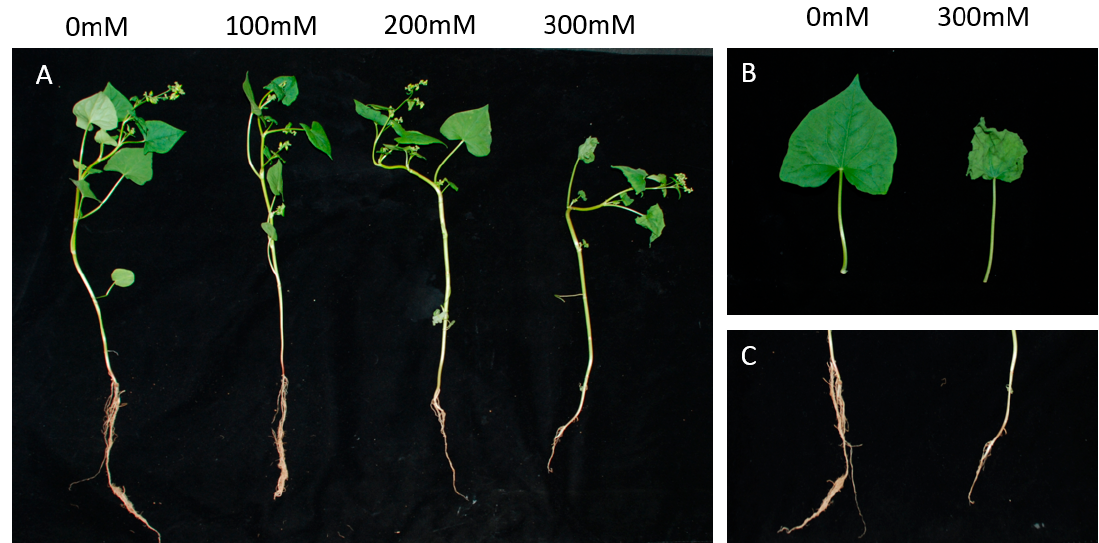
Figure 2. Morphology of whole plants ( A ), leaves ( B ), and roots ( C ) in response to salt stress.